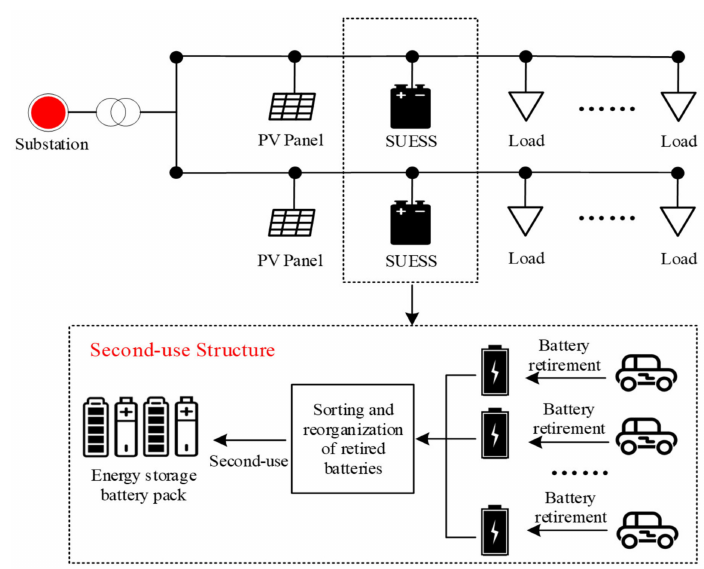
Figure 1. Simplified structure of distribution network with second-use electric vehicle energy storage system.